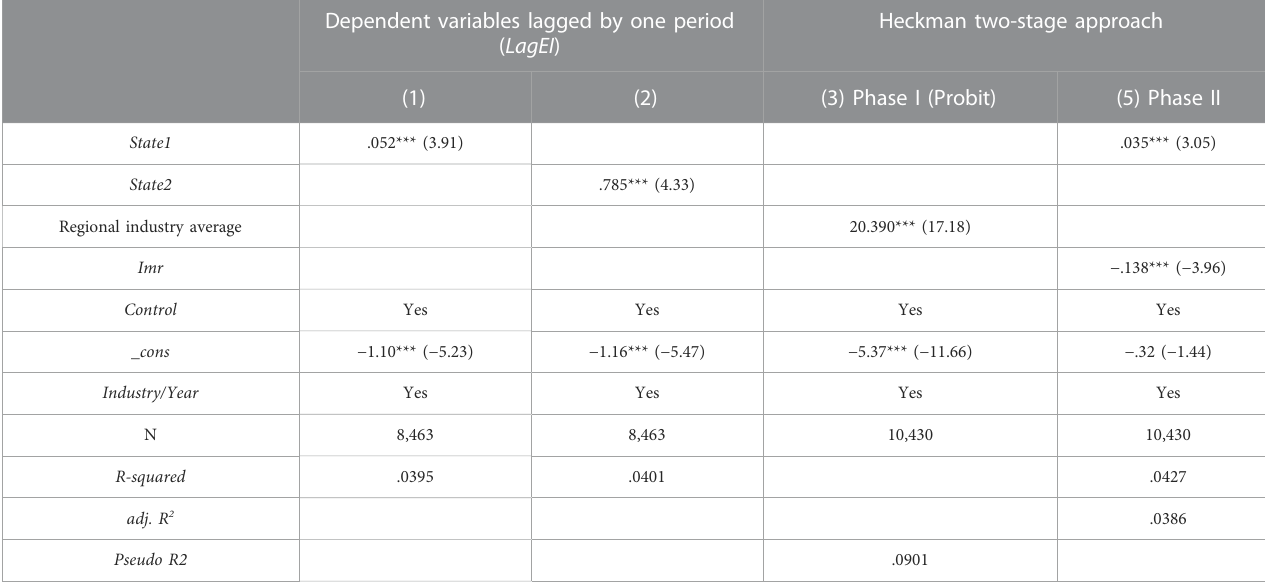
TABLE 8 Robustness test results2.